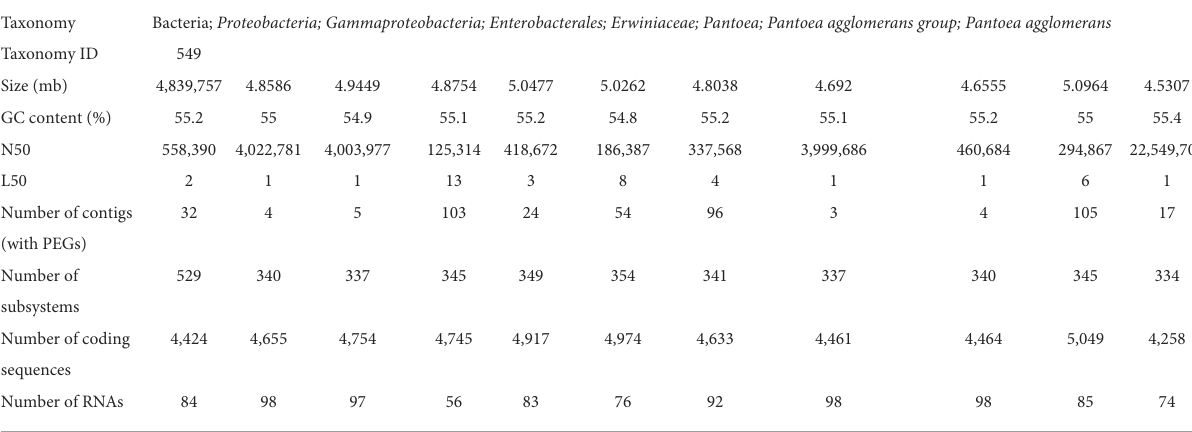
TABLE 1 Pantoea agglomerans strains genome used for comparative study.